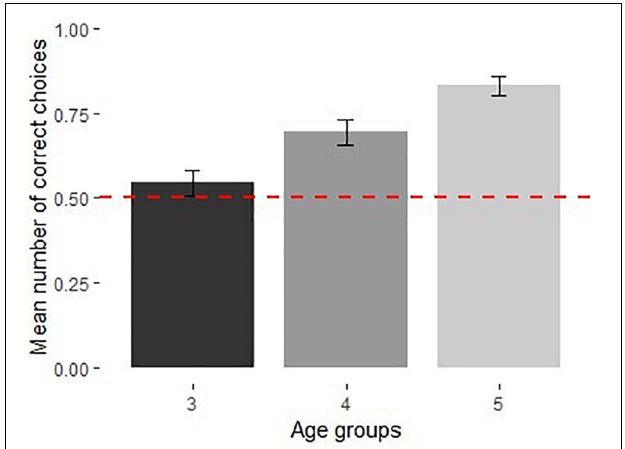
FIGURE 7 | Performance of 3–5-year-olds in shaken boxes in Experiment 4 ( N = 48). Dotted line shows chance level performance ( p = 0.05), error bars represent SE .